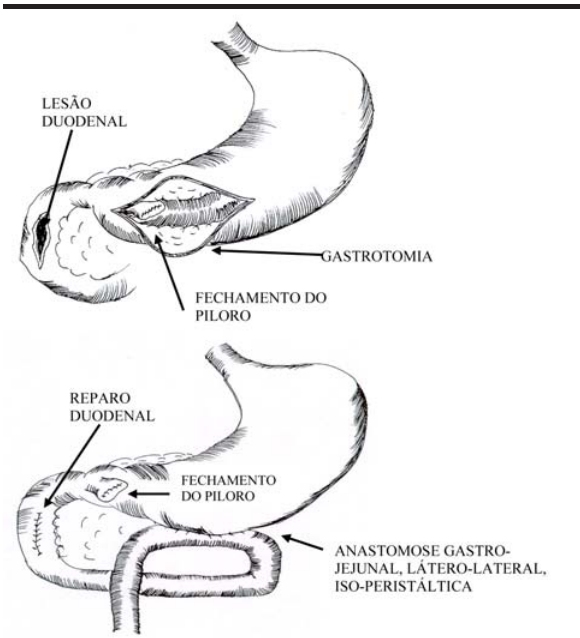
FIGURA 1: Sutura da lesão duodenal associada à exclusão pilórica e gastrojejunostomia